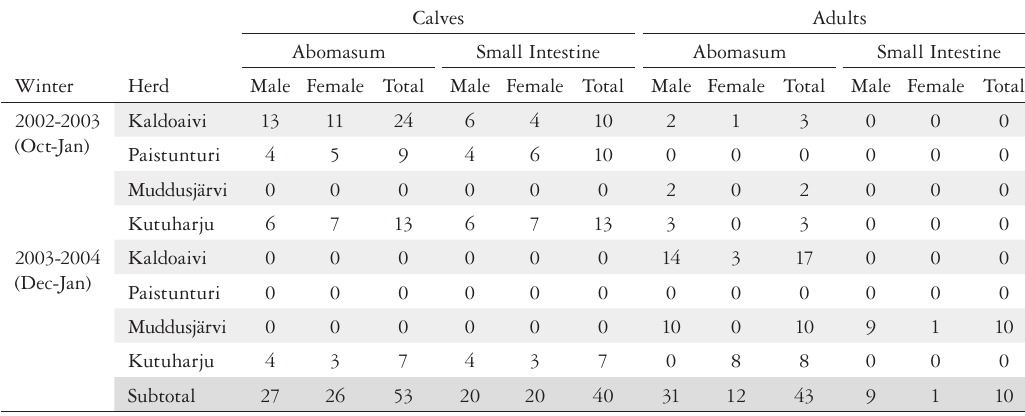
Table 1. Inventory of biological samples examined for gastrointestinal nematodes from reindeer ( Rangifer tarandus ) calves and adults from four herds in northern